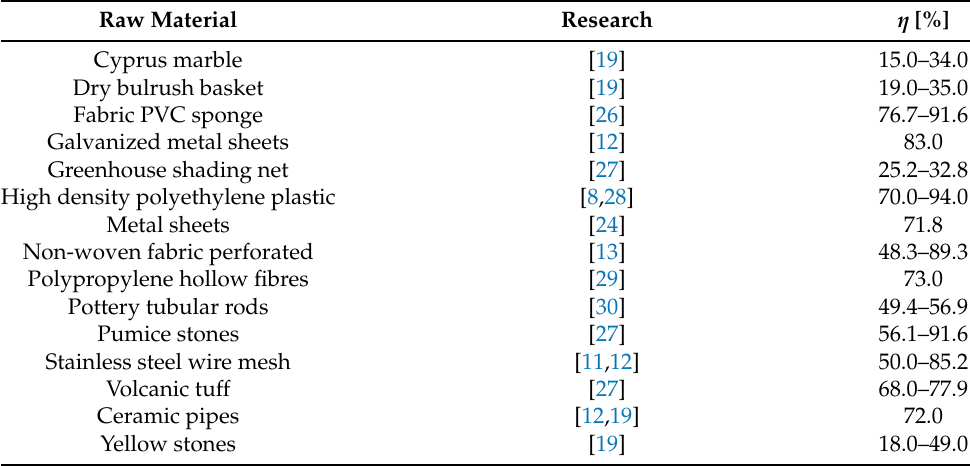
Table 2. Cooling efficiency ( η ) of cooling pad research studies based on inorganic raw